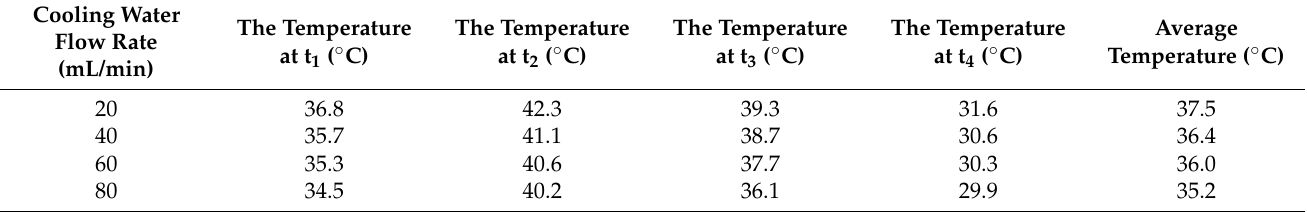
Table 1. The cooling effect of the copper plate under different cooling water flow